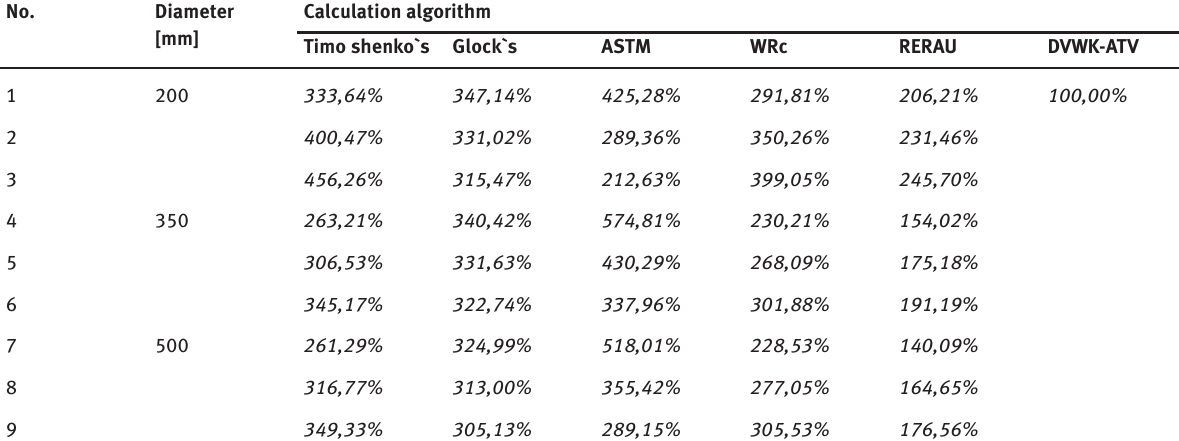
Table 3: Percentage differences of results in each